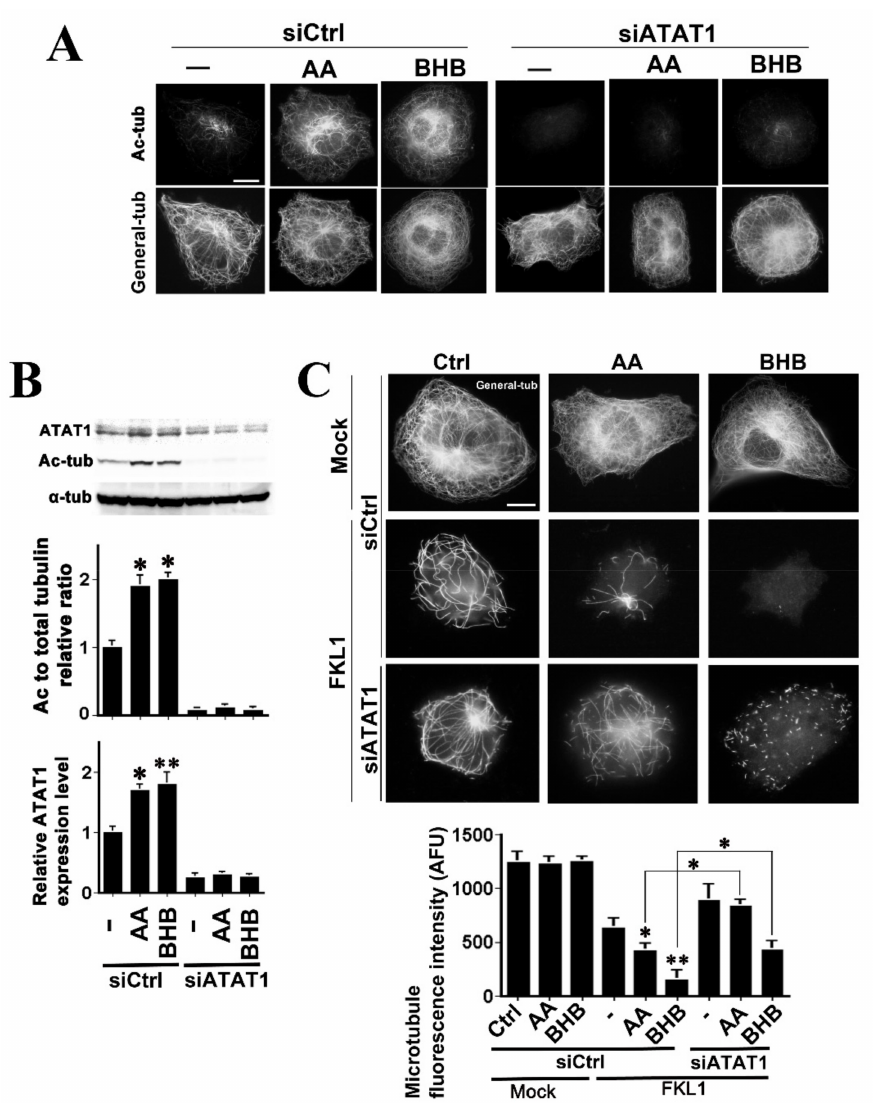
Figure 3. Effects of ketone body-induced microtubule acetylation on KL1-mediated microtubule severing in IMR90-SV cells. ( A ) Effects of ketone body treatment on cellular microtubule acetylation in IMR90-SV cells. Cells were transfected with an siRNA against ATAT1, treated with 10 mM AA or 20 mM BHB, cultured, and then stained with anti-tubulin and anti-acetylated-tubulin antibodies. In the immunofluorescence images, the upper panels indicate acetylated tubulin (Ac-tub), and the lower panels denote the corresponding general tubulin (General-tub) images. There was no difference between the untransfected cells and the control siRNA transfected cells. Compared with the control cells (siCtrl), both AA- and BHB-treated cells showed significant increase in microtubule acetylation. Under the ATAT1 knockdown, only a marginal acetylated-tubulin signal was detectable, regardless of the treatment by different ketone bodies. The quantification data are described in the results section. Scale bar, 10 µ m. ( B ) Under the same set of conditions as in ( A ), immunoblotting was performed using anti-ATAT1, anti-acetylated-tubulin, and anti- α -tubulin antibodies. Quantification data are shown in the graphs below the panels. Significant increases in microtubule acetylation were detectable in the AA- and BHB-treated cells compared with the controls. The anti-ATAT1 siRNA transfection reduced the Ac to α -tubulin ratios to very low levels regardless of the presence of ketone bodies (upper graph). Anti-ATAT1 blots indicated significant increases in the response to AA or BHB treatments in the control cells. Under siATAT1 transfection, 70–80% reductions in ATAT1 levels